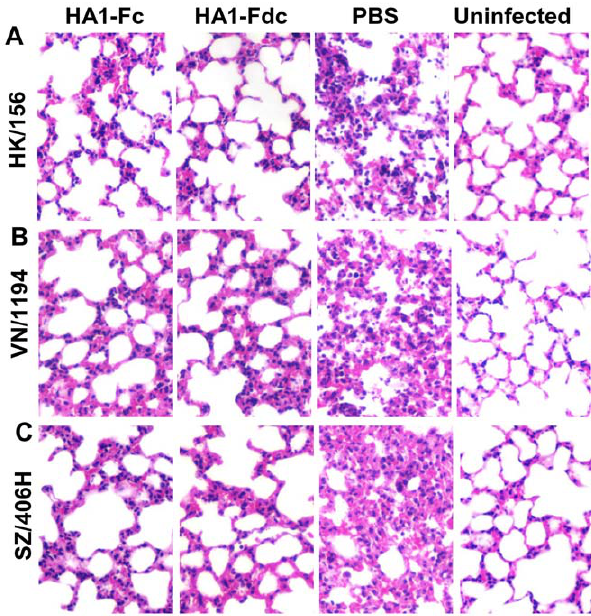
Figure 8. Evaluation of histopathological changes in lung tissues of H5N1 virus-challenged mice. HA1-Fc- and HA1-Fdc- vaccinated mice were challenged with 10 LD 50 of three clades (clade 0: HK/156, clade 1: VN/1194, and clade 2.3.4: SZ/406H) of H5N1, and lung tissues were collected at day 5 post-challenge. Lung tissues from mice injected with PBS and those of uninfected mice were used as negative and normal controls, respectively. All sections of lung tissues were stained with hematoxylin and eosin (H&E) and observed under light microscope (magnification, 100 6 ). Representative image of histopath- ological damage from mice challenged with HK/156 (A), VN/1194 (B), and SZ/406H (C) H5N1 virus was shown.